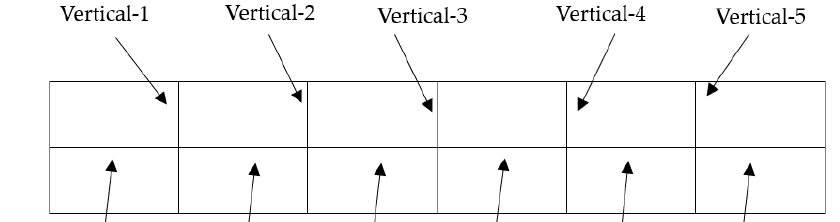
Figure 2. Dissection Direction.